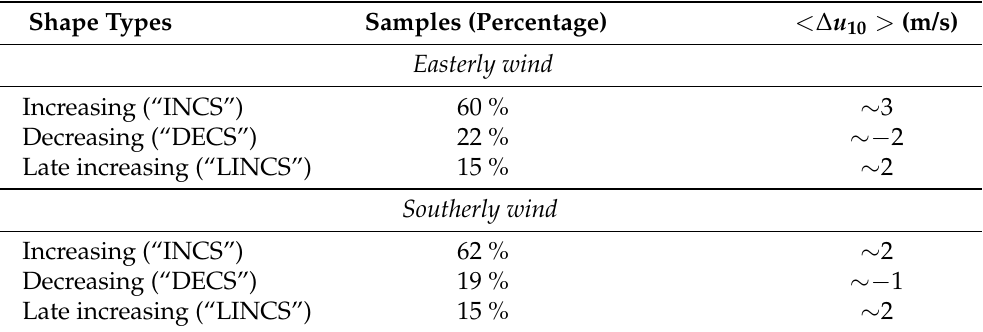
Table 2. Three different groups of the shape of the horizontal wind gradients found in four-year period for easterly and southerly wind